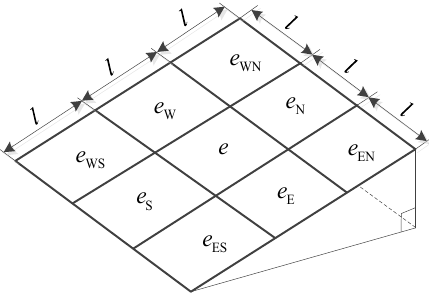
Figure 2. Schematic of the lunar rover’s current region R